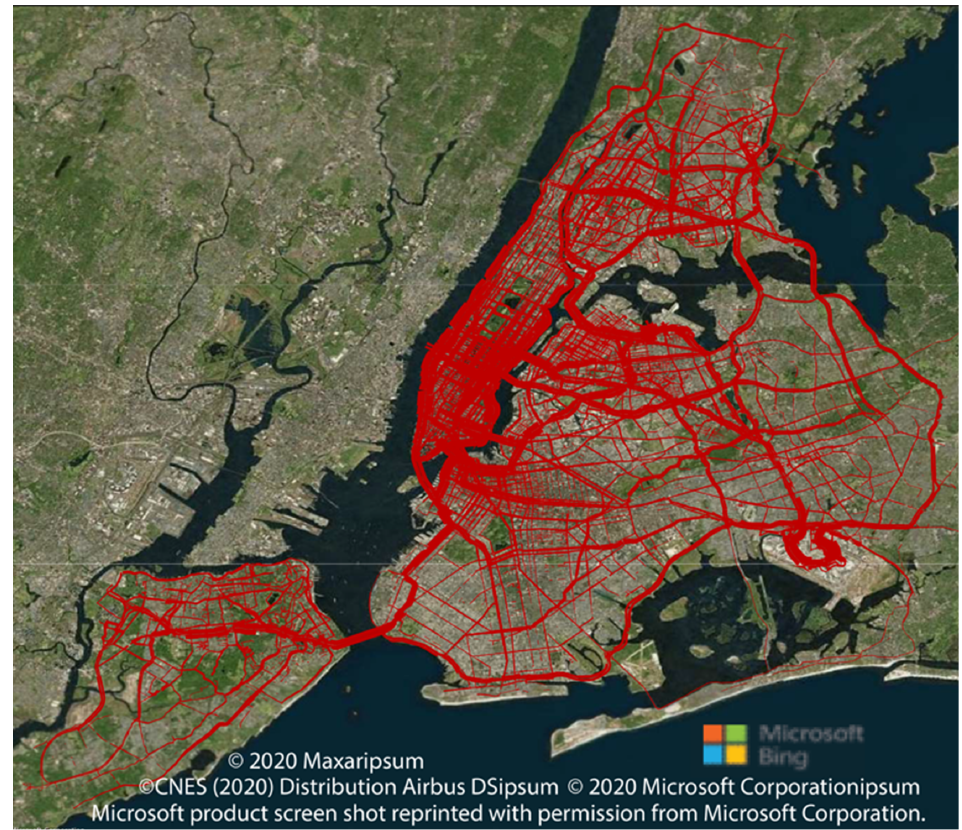
Figure 5. Traffic flow (baseline scenario 1) (created with PTV VISUM 20.01, printed with permission from PTV Planung Transport Verkehr GmbH).